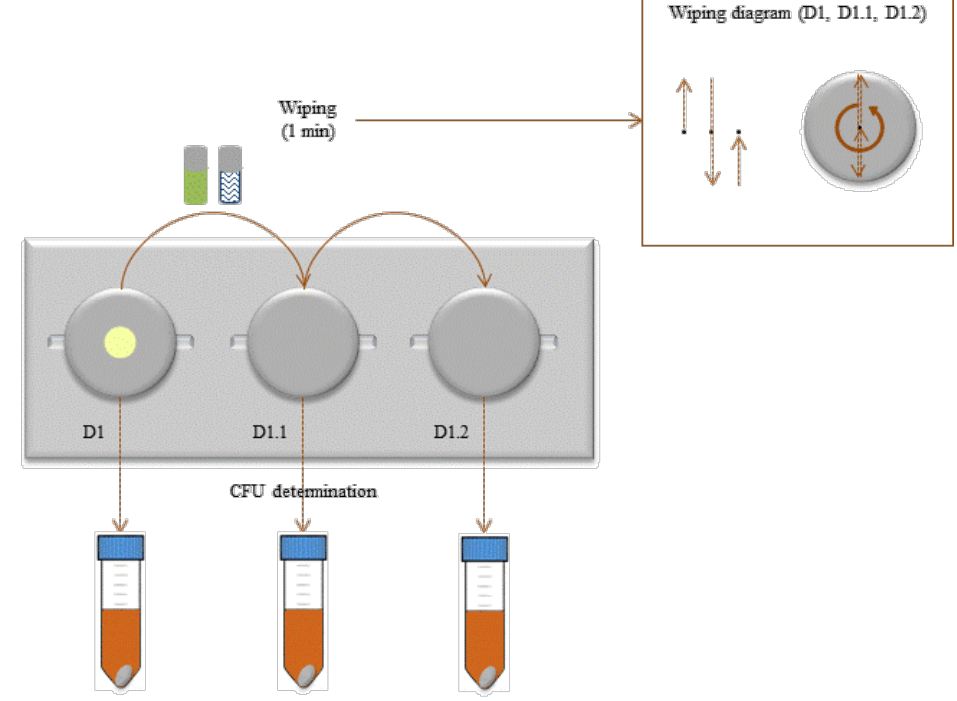
Figure 8. Schematic representation of the wiping assay steps.